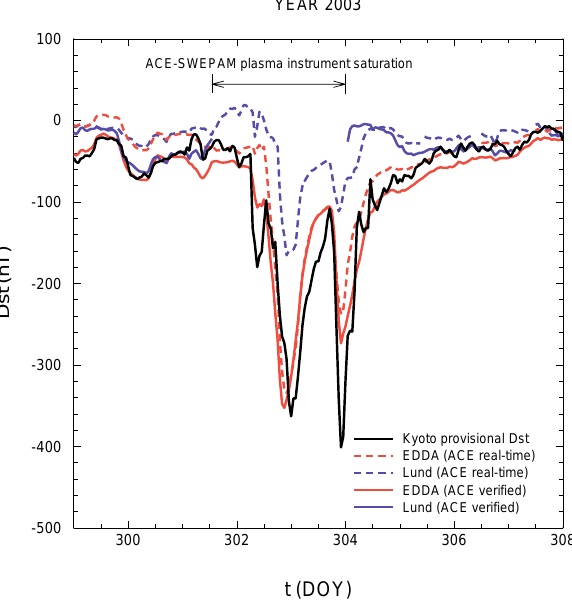
Fig. 6. Performance of the EDDA and “Lund models” (inputs: B z ,N p ,V p ) for two storms in October 2003 when the ACE plasma instrument malfunctioned (see details in the